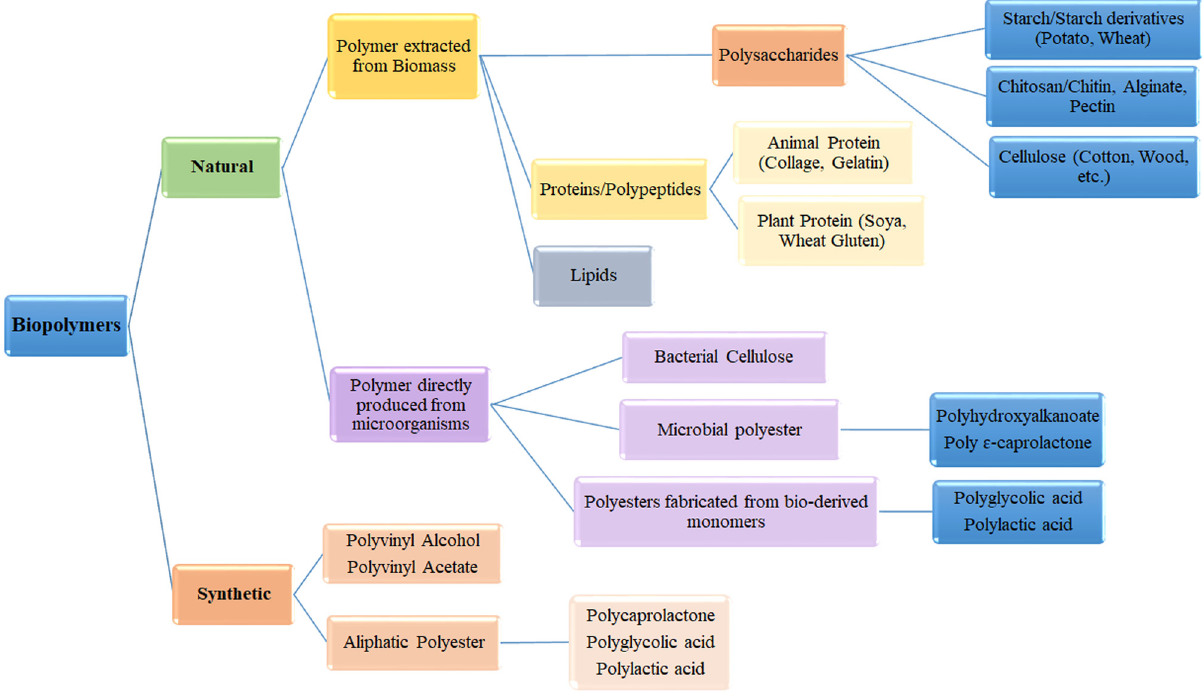
Figure 1: Classi fi cation of biopolymers ( reprinted with permission from refs [ 5,6 ])